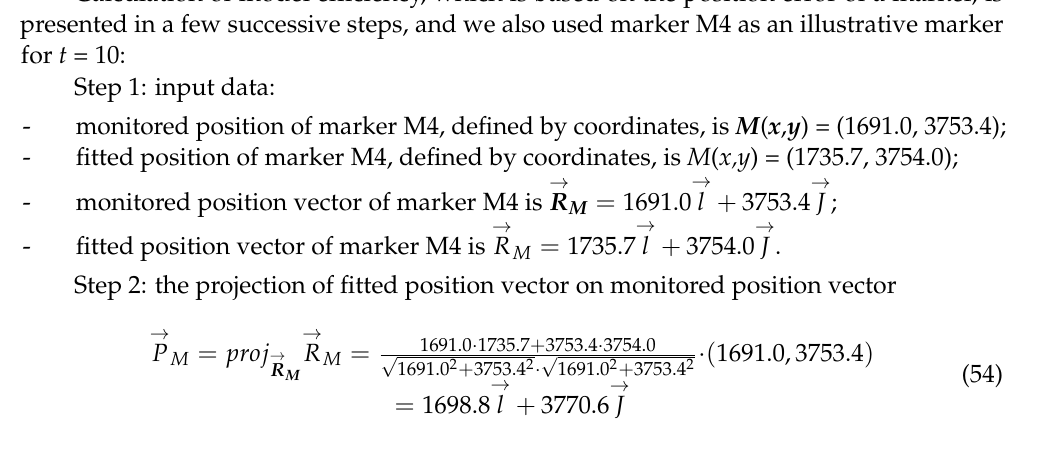
Figure 17. Steel arch support shape for t = 0, 10, 25, 30 days (monitored, fitted, and forecasted data).